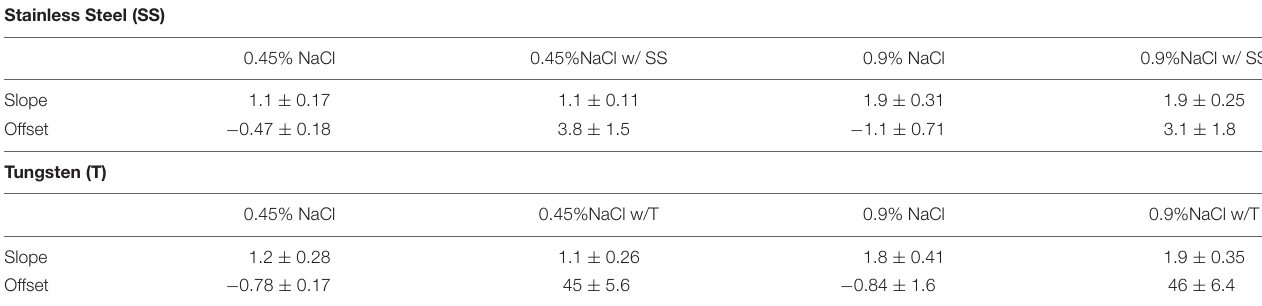
TABLE 1 | The calibration slope and offset of the impedance catheter in NaCl and NaCl plus wire coil (stainless steel and tungsten). Stainless Steel